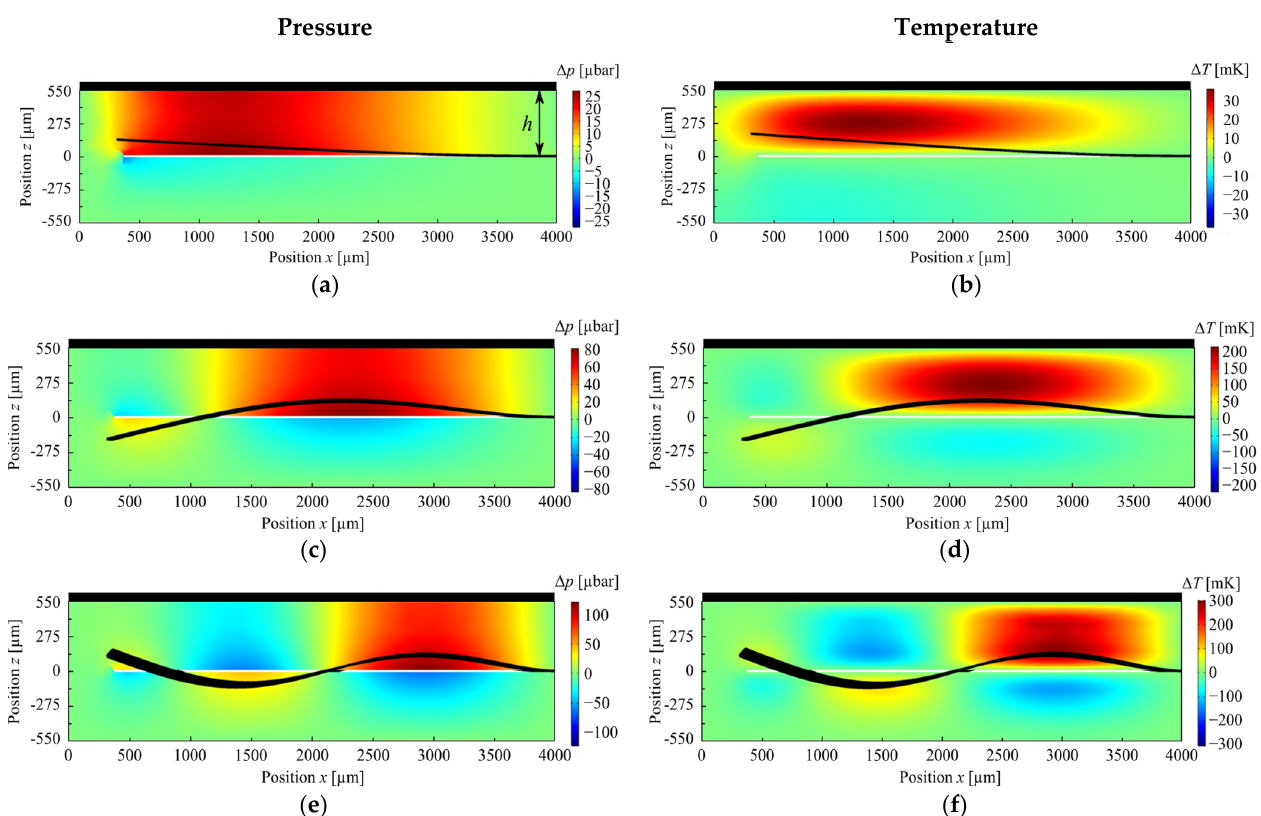
Figure 2. FEM-simulated pressure and temperature distribution for CO1 ( cf. Table 1) at a gap width of 550 µm. In ( a , c , e ), the pressure distribution of the 1st, 2nd, and 3rd BM is displayed, respectively. In ( b , d , f ), the corresponding temperature distribution of the 1st, 2nd, and 3rd BM is shown. The ambient values are indicated by a green color. Deviations to the top are shown by red, or to the bottom by blue. The oscillator deflection (black) of the bending mode is shown enlarged and not to scale.